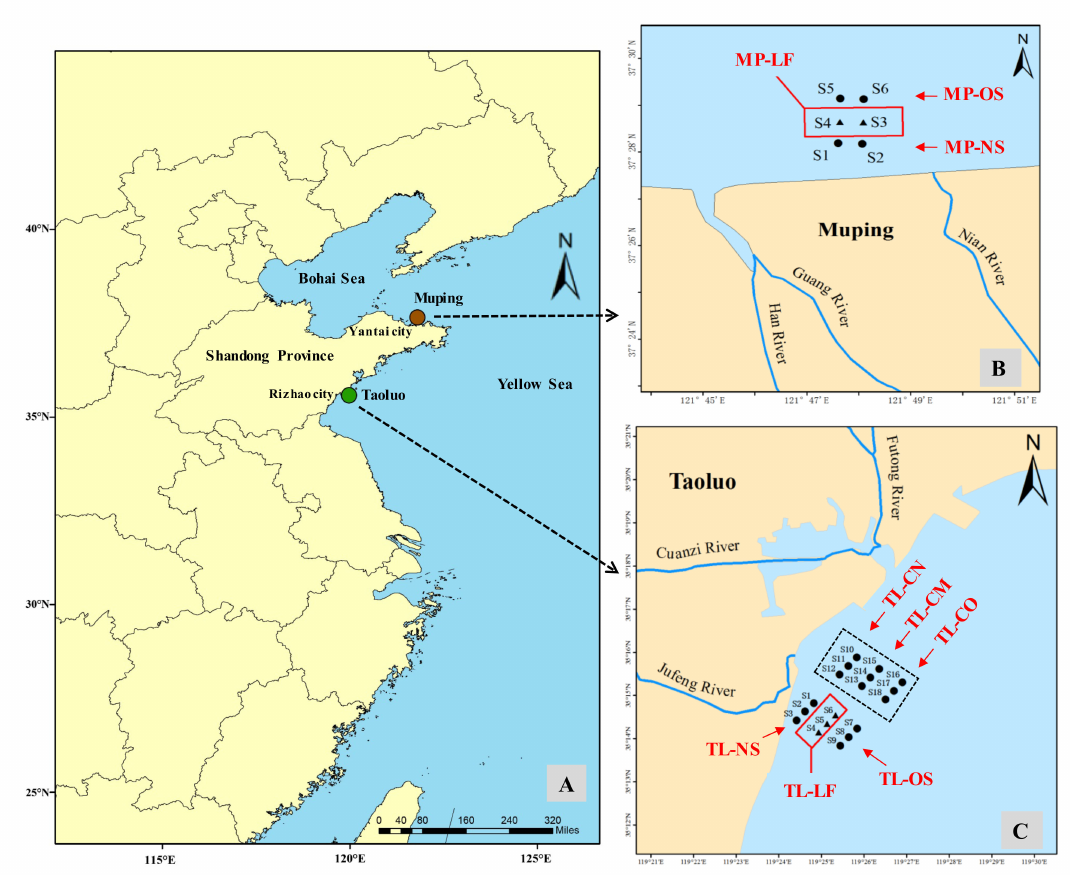
Figure 1. Map of the study areas. ( A ) Locations of the two study areas in Shandong Province, China. The brown and green dots indicate the sampling stations of Muping and Taoluo, respectively; ( B ) The sampling points in Muping, with two river estuaries (Han River and Guang River) in the west and Nian River estuary in the east. The red rectangle indicates a small-scale laver culture area (MP-LF, sampling points of S3–S4). The nearshore and offshore areas 100 m away from MP-LF were represented as MP-NS (sampling points of S1–S2) and MP-OS (sampling points of S5–S6), respectively. ( C ) The sampling points in Taoluo, with Jufeng River estuary in the west and Futong River estuary in the north. The red rectangle and black rectangle indicate a large-scale laver culture area (TL-LF, sampling points of S4–S6) and a reference site with no culture activities, respectively. The nearshore and offshore areas approximately 1 km away from TL-LF were represented as TL-NS (sampling points of S1–S3) and TL-OS (sampling points of S7–S9), respectively. In the reference site, three sampling